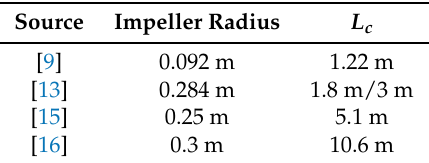
Table 2. Comparison of values of L c parameters and radii of impellers for several Greitzer model applications presented in the